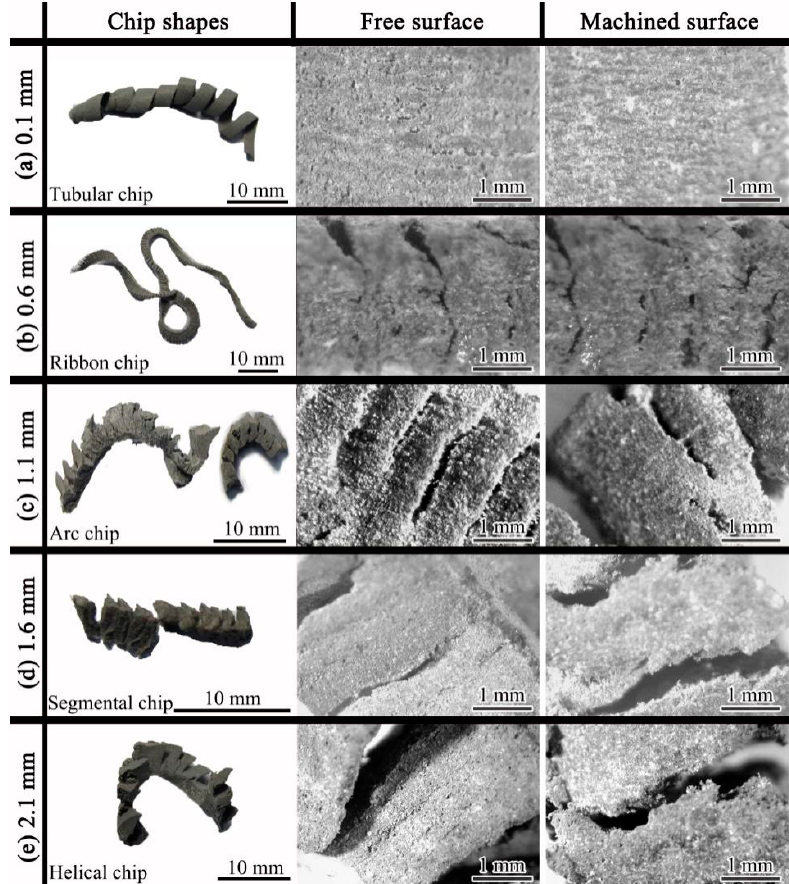
Figure 10. Chip formation at different cutting depths, where the free and machined surfaces are the noncontact and contact surfaces of chip and rake face, respectively: ( a ) 0.1 mm, ( b ) 0.6 mm, ( c ) 1.1 mm, ( d ) 1.6 mm, and ( e ) 2.1